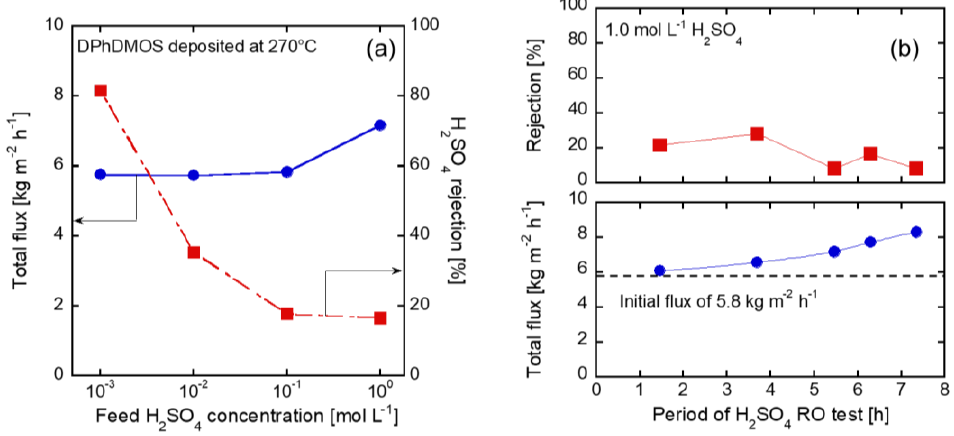
Figure 6. ( a ) Each H 2 SO 4 concentration solution of the RO test, ( b ) the time course change of 1 mol L −1 H 2 SO 4 RO test.